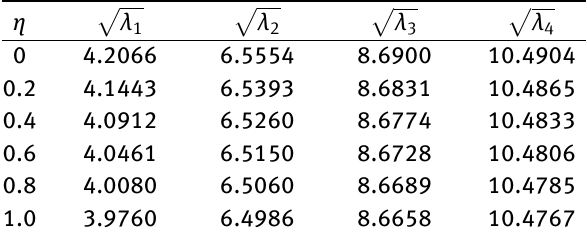
Table 15: Frequency parameter ( uniform parameter